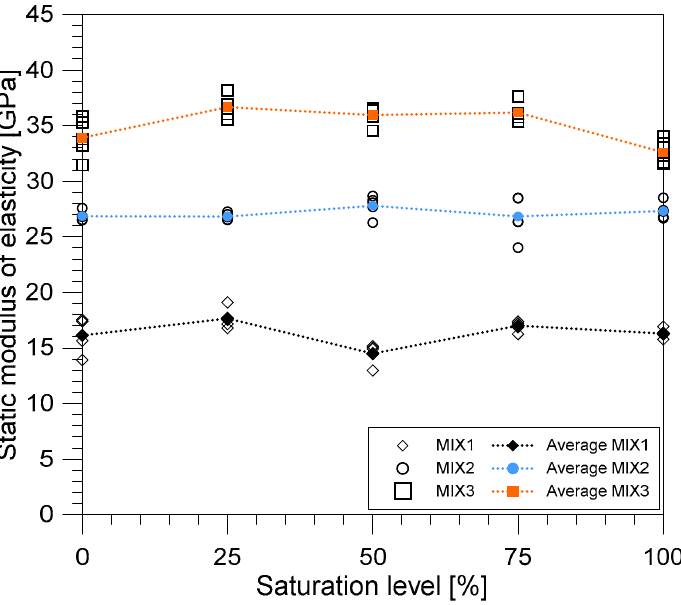
Figure 13. The variation of static modulus of elasticity of concrete with saturation condition.